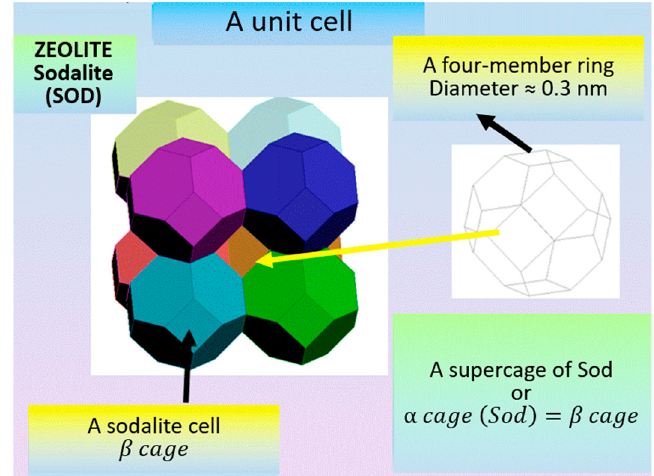
Figure 9. Sodalite unit cell [compiled by the authors].